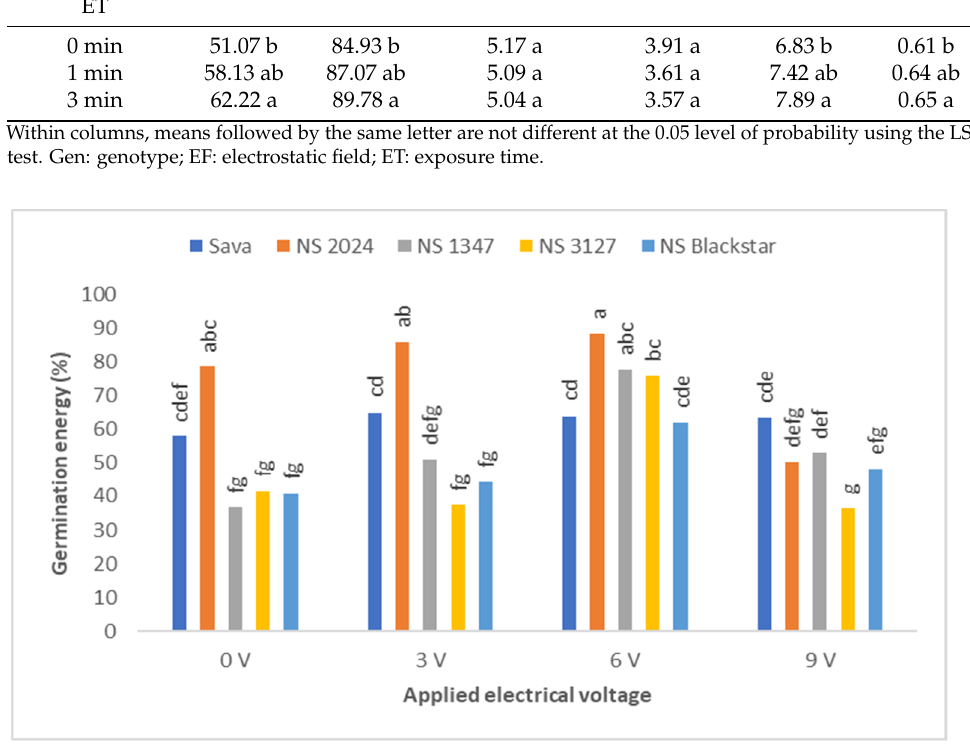
Within columns, means followed by the same letter are not different at the 0.05 level of probability using the LSD test. Gen: genotype; EF: electrostatic field; ET: exposure time. A significant difference in the interaction of genotype × intensity electrostatic field was determined for GE (Figure 3). In particular, by applying 3 V, the GE was significantly increased in all genotypes except for brown-gen, where there was a reduction of GE. The GE increase ranged from 08.26% to 28.10% compared to the respective control, and the